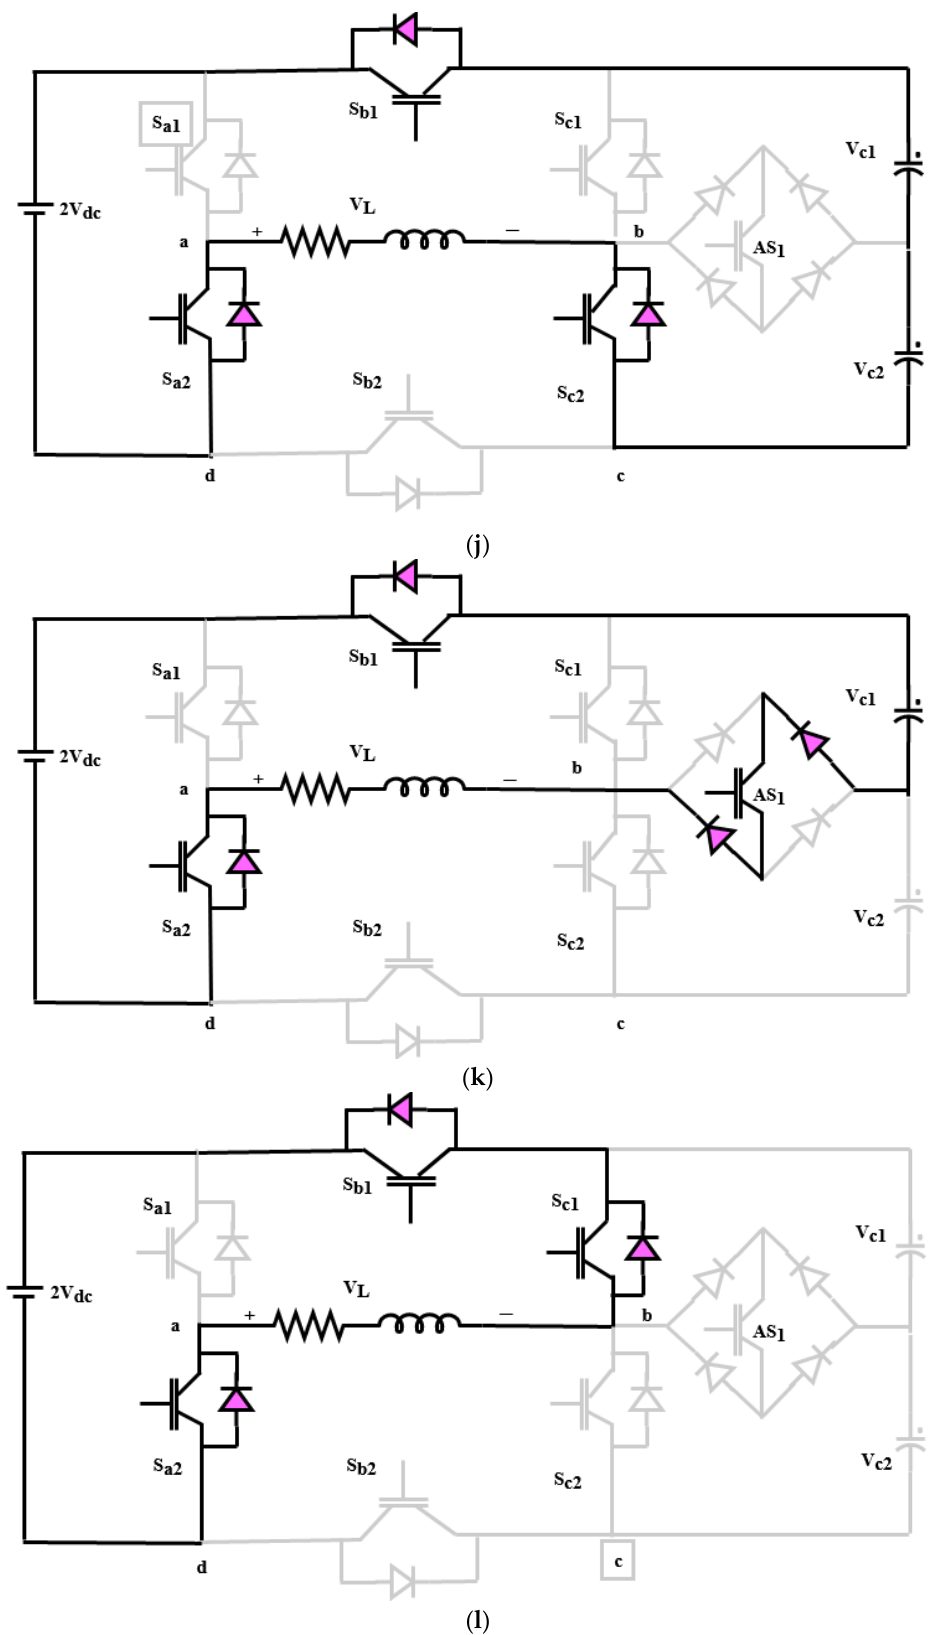
Figure 8. Switching states of nine-level inverter. ( a ). State 1, ( b ). State 2, ( c ). State 3, ( d ). State 4, ( e ). State 5, ( f ). State 6, ( g ). State 7, ( h ). State 8, ( i ). State 9, ( j ). State 10, ( k ). State 11, and ( l ). State 12